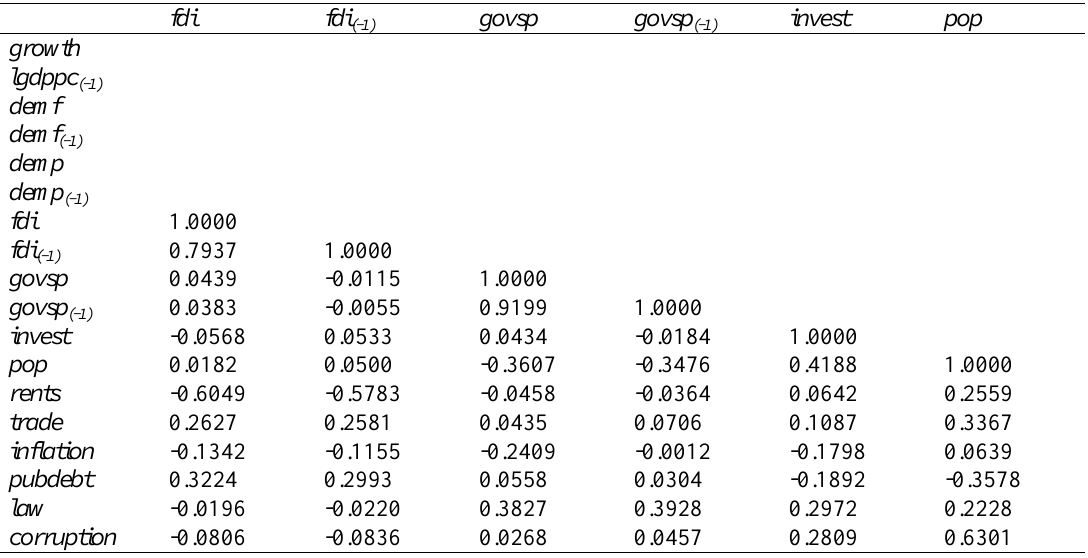
Table A.3: Correlation matrix (continued)